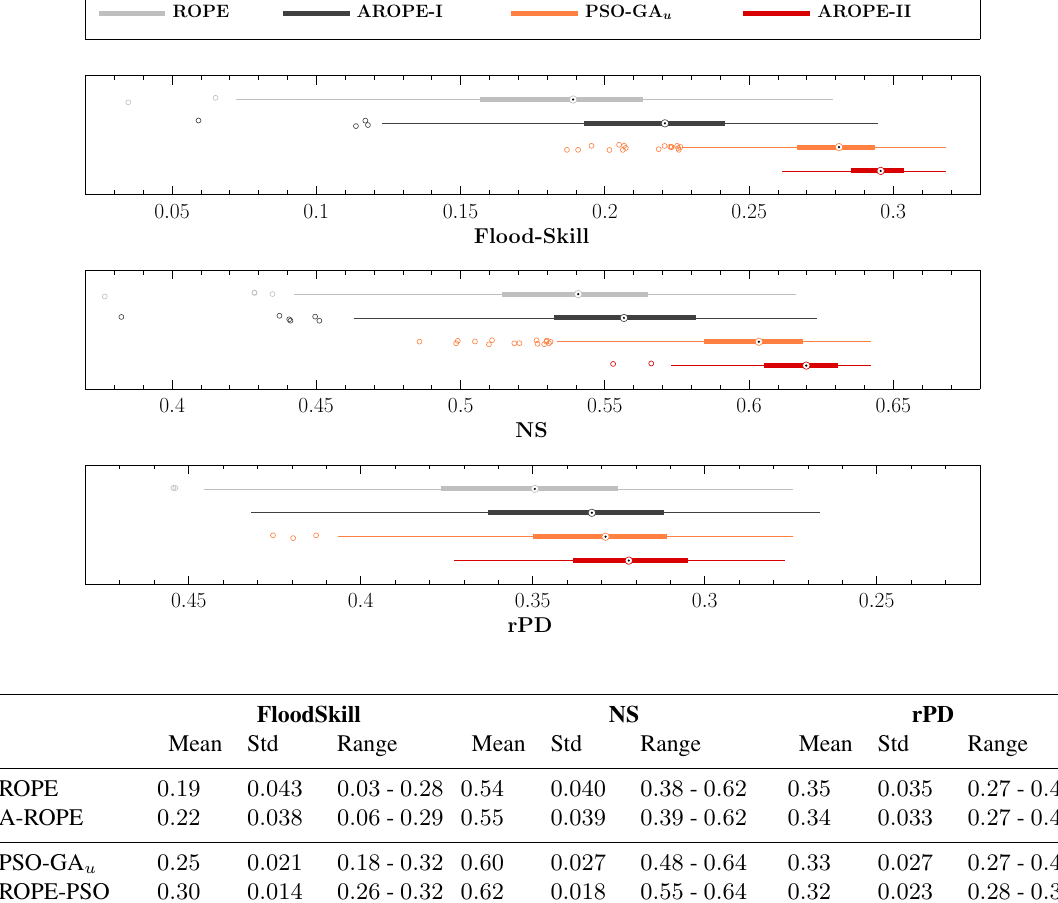
Fig. 17: Validation performance for the parameter vectors estimated by ROPE, A-ROPE, PSO-GA u and ROPE-PSO.